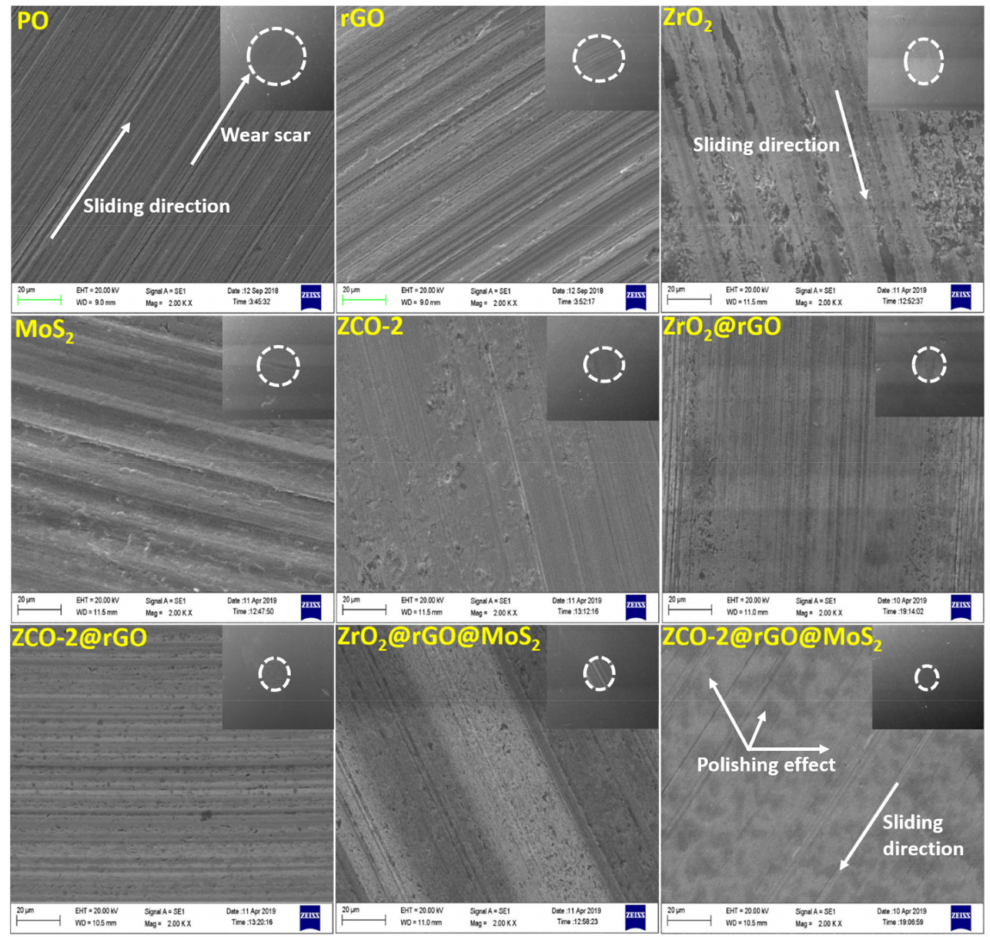
Figure 9. SEM micrographs (inset: Full view of wear scar at 100 × , wear scar surface at 2000 × magnification) of the worn steel surface lubricated with para ffi n oil with and without di ff erent nano additives (0.125% w / v) for 60 min test duration at 392 N applied load.